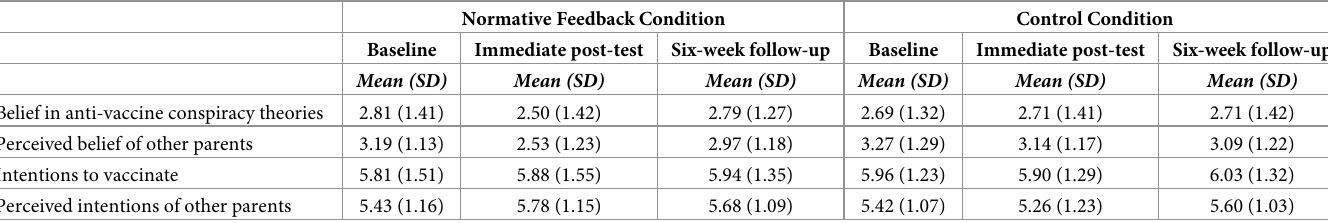
Table 2. Means and standard deviations of each dependent variable for each condition across the three time